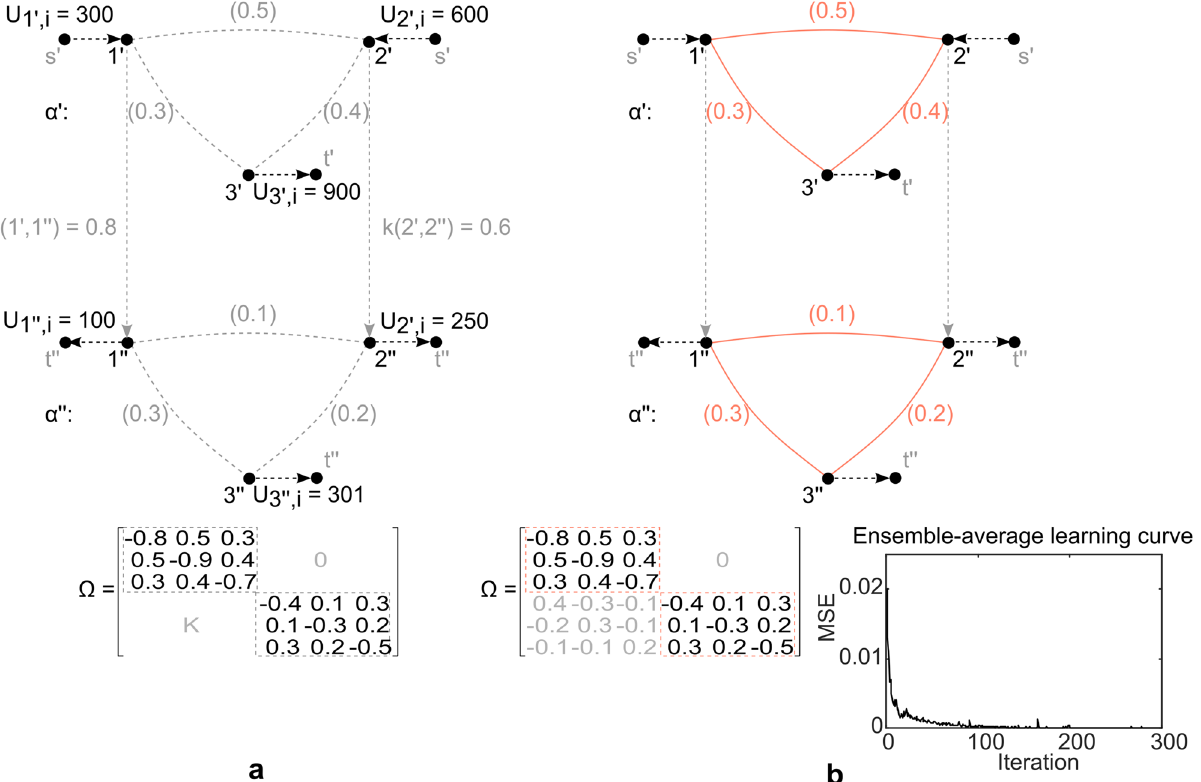
Figure 4. Simplified illustration of heterogeneous multilayer flow network (relationship) inference. ( a ) Illustrative heterogeneous multilayer flow network, with known features (nodes { 1 ′ , . . . , 3 ′′ } ), and labelled outcomes (exogenous arcs { ( s ′ , 1 ′ ) , . . . , ( 3 ′′ , t ′′ ) } ), by observation i (black), as well as unknown topology (grey) depicted as ground truth (corresponding to weights). Note that block matrix K is flow dependent (Eq. 18). ( b ) Derived multilayer network topology, based on LMS adaptive algorithm applied to dataset corresponding to panel a. Ensemble-average learning curve, MSE i = 1 / R (cid:31) R [ U i + � i − 1 q i ] 2 R 52 , corresponding to algorithm performance, obtained over 30 experiments R . Note that exogenous block entries of (cid:31) (corresponding to K ) relate to conversion of centred data. When solving for e.g., multilayer network flow, this would not pose a limitation, as one could derive the node potentials q based on the obtained weight matrix (cid:31) (i.e., its pseudoinverse) and the given exogenous flow U . Ultimately, this would not distort the flow derivation, as potentials are fixed to within a constant (here average). Derivation of exact conversion coefficients k , however, would require additional constraints and a different approach, which is outside of scope for